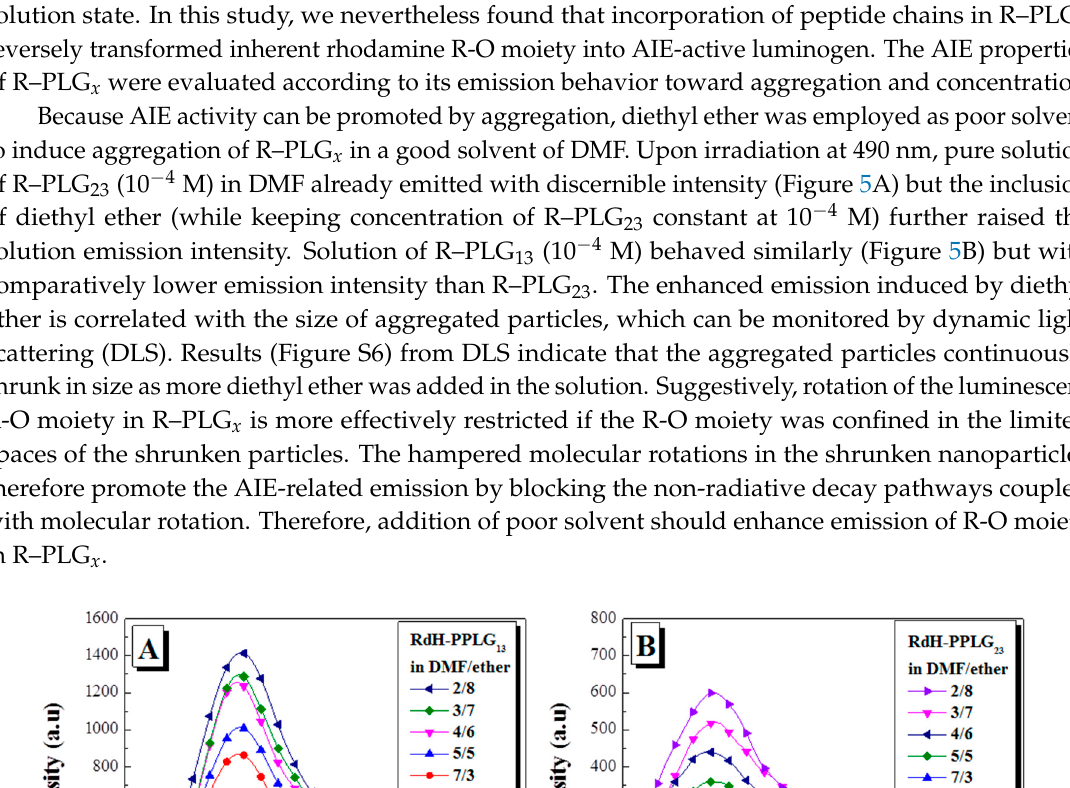
Table 1. Molecular weight of R–PLG 13 and R–PLG 23 evaluated from 1 H NMR and Maldi-Tof mass spectra and fractions of secondary structure determined from FTIR and CD spectra.